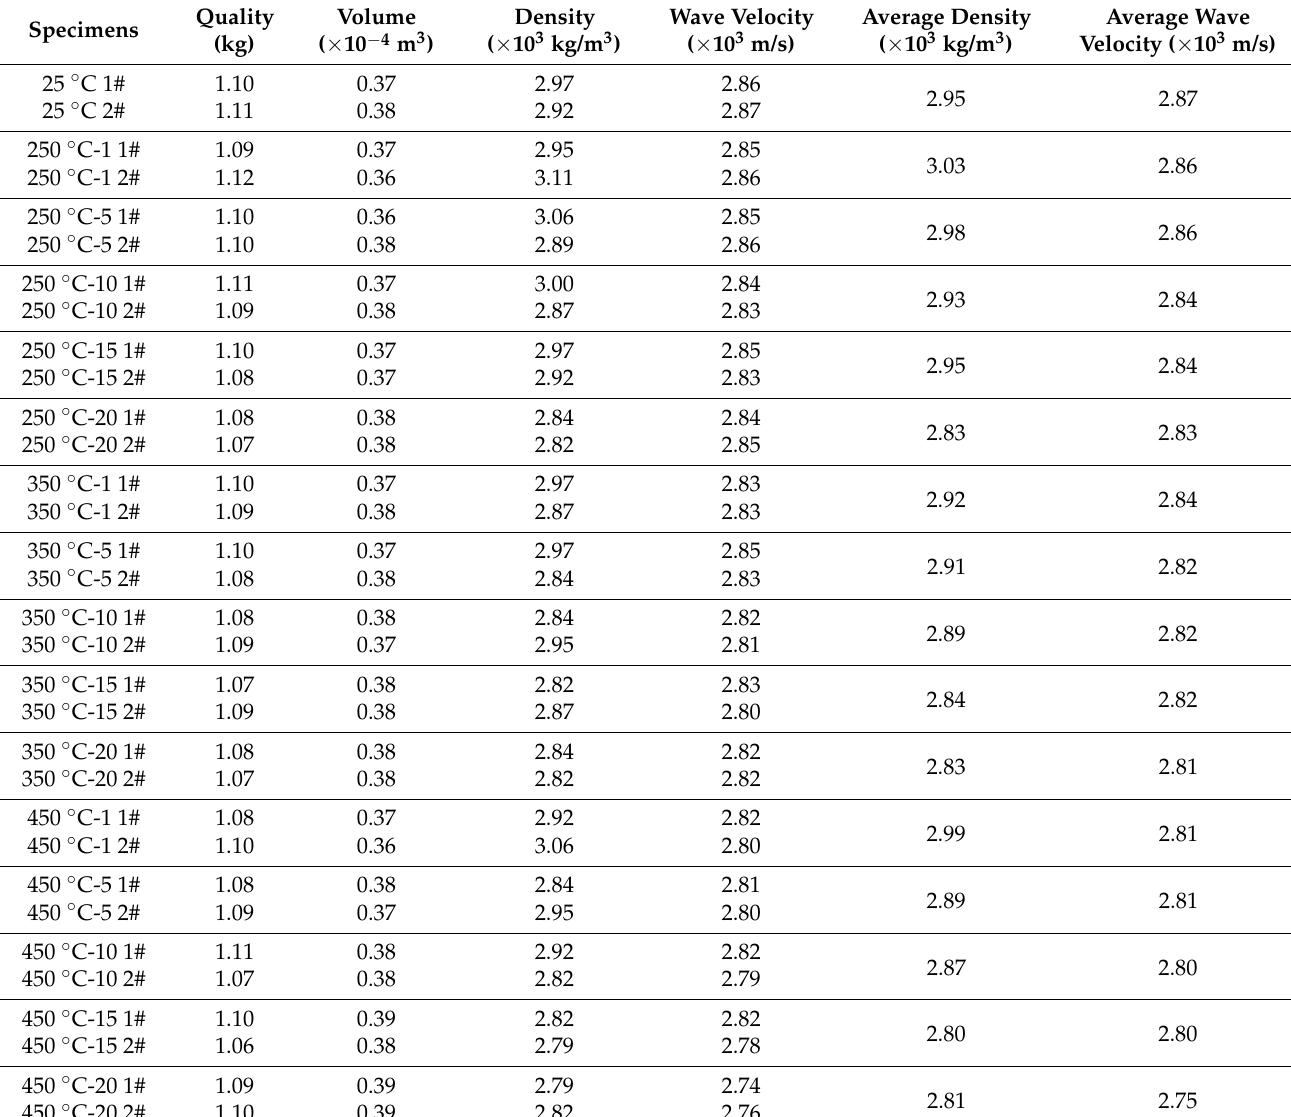
Table 1. Basic physical parameters of the treated specimens.